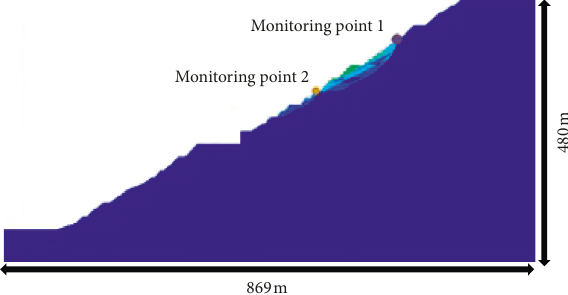
Figure 27: Layout of the landslide